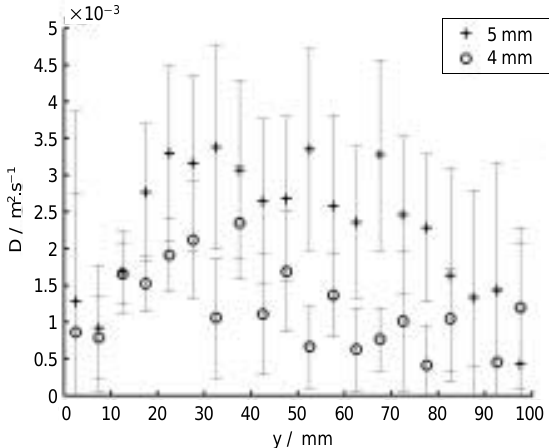
Fig. 11 Self-diffusion coefficient as a function of altitude, ex- tracted from the displacement probability functions using equation (6), for the bi-disperse case. Errors bars are shown representing the standard deviation of the